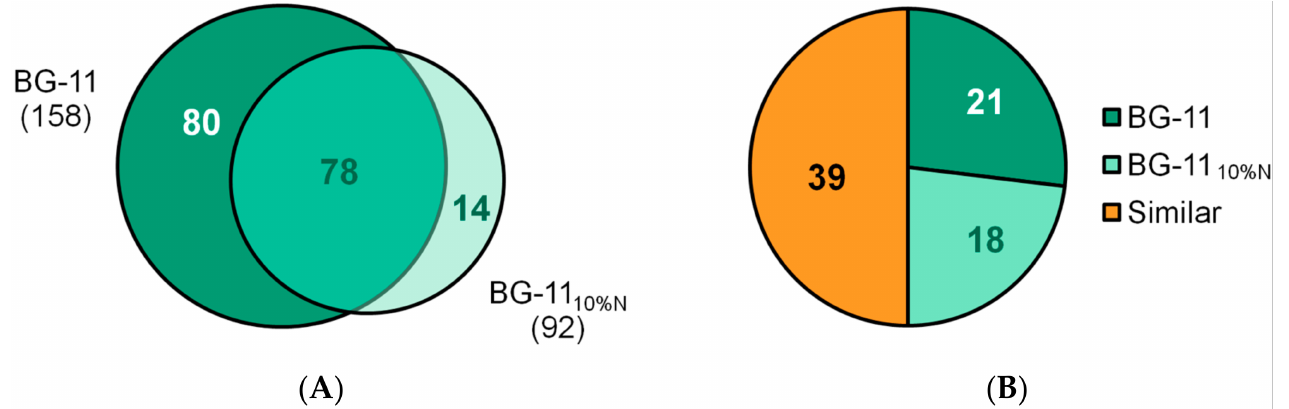
Figure 4. Protein detection profile. ( A ) Venn diagram of proteins identified exclusively in BG-11 and BG-11 10% N and in both conditions (intersection); ( B ) proteins up-regulated in each sample, as well as those with similar